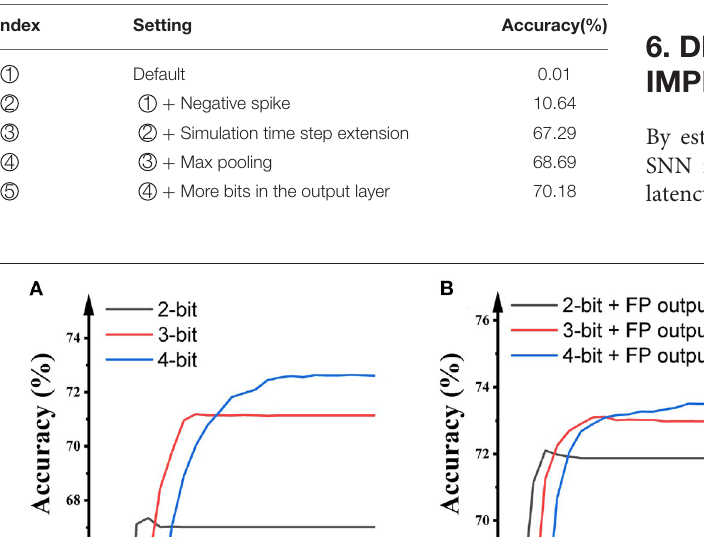
TABLE 4 | Ablation studies on ImageNet.